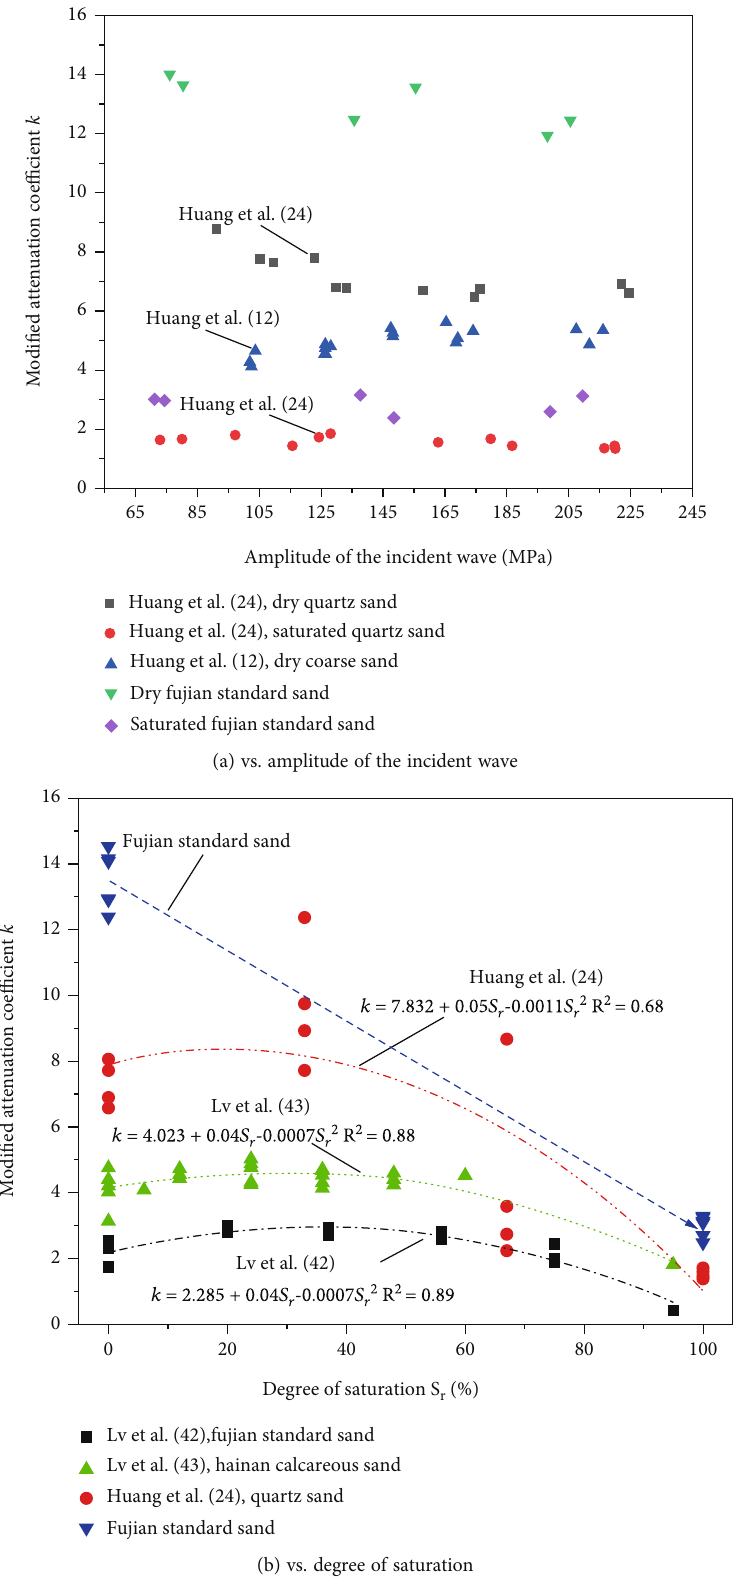
Figure 11: The variation of a modi fi ed attenuation coe ffi